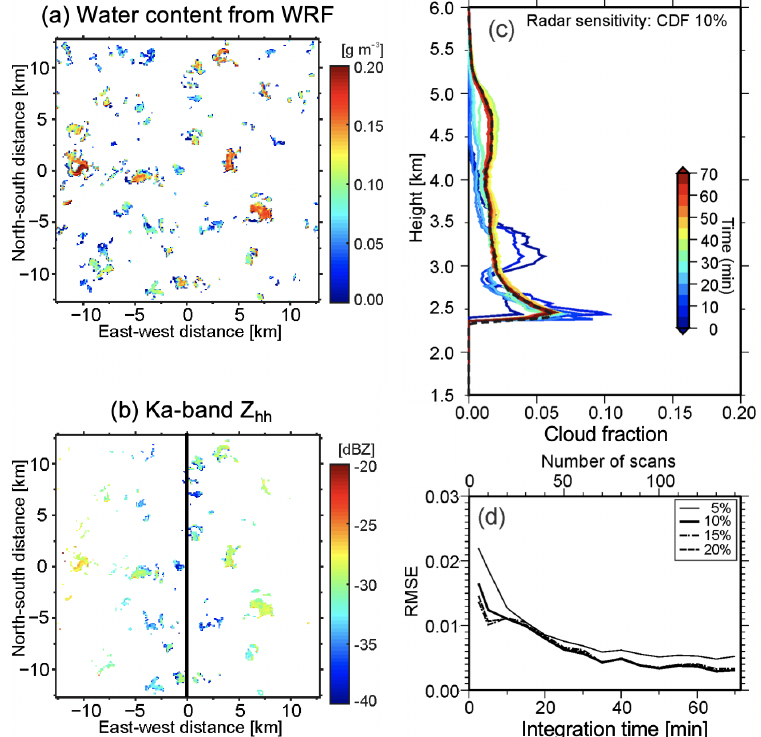
Figure 8. Horizontal cross sections of (a) water content simulated by WRF and (b) Ka-band (35GHz) Z hh simulated at 2.4km above ground level for a LASSO case. In (b) , it is assumed that the radar is located at x = 0km and the RHI is scanned along the east–west axis, and the radar sensitivity Z MIN with C 0 = − 50dBZ was applied. (c) Cloud fraction profiles corresponding to the 10% cumulative distribution function (CDF) isoline with changing integration time of CWRHI (hence, number of scans). (d) The root-mean-square error (RMSE) from the LES domain-averaged CFP for CDF isolines of 5% (thin solid line), 10% (thick solid line), 15% (dashed line), and 20% (dashed-dotted line) as a function of integration time. The black dashed line in (c) represents the LES domain-averaged CFP for hydrometeor mixing ratio ≥ 0 . 01gkg − 1 . (c) and (d) are adapted from Oue et al. (2016).